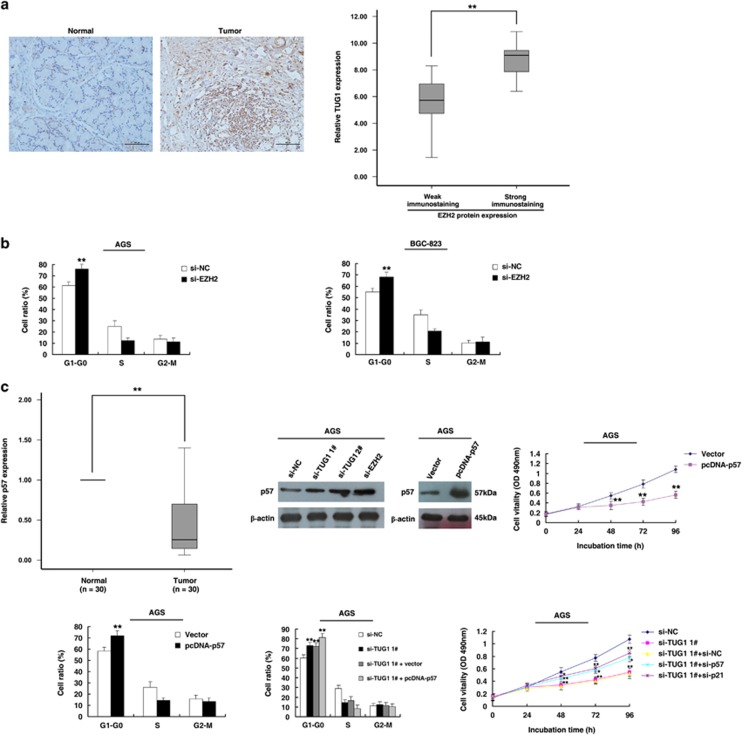
The role of p57 in GC. (a) Immunohistochemistry was used to detect the expression of EZH2 protein in 30 pairs of GC with corresponding non-tumor tissues. Bar, 100μm. The immunoreactivity of EZH2 protein in GC tissues showed a statistically significant positive correlation with the relative level of TUG1 expression. (b) AGS and BGC-823 cells transfected with si-NC/si-EZH2. Forty-eight hours after transfection, the cells were analyzed using flow cytometry. (c) As determined by qRT-PCR assays, the level of p57 was downregulated in 30 pairs of GC tissues. Western blot assays detected the expression of p57 after transfection. AGS cells were transfected with Vector/p57. Forty-eight hours after transfection, the cells were analyzed using MTT assays and flow cytometry. AGS cells were transfected with si-NC/si-TUG1/si-TUG1+vector and transfected with si-TUG1 followed by transfection with pcDNA-p57. After transfection, the cells were stained and analyzed using flow cytometry. MTT analysis of cell proliferation by co-transfection (si-NC, si-TUG1 1#, si-TUG1 1#+si-NC, si-TUG1 1#+si-p57, si-TUG1 1#+si-p21). *P<0.05, **P<0.01